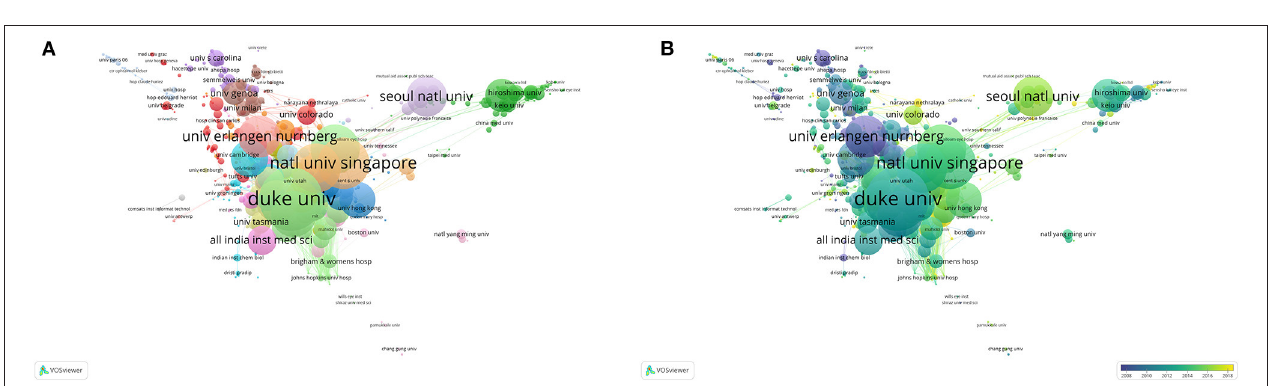
FIGURE 4 | Cooperation map of output institution in the studies of POAG. (A) Institution network; (B) Institution overlay. Explanatory figure legend is the same as that of Figure 2 .